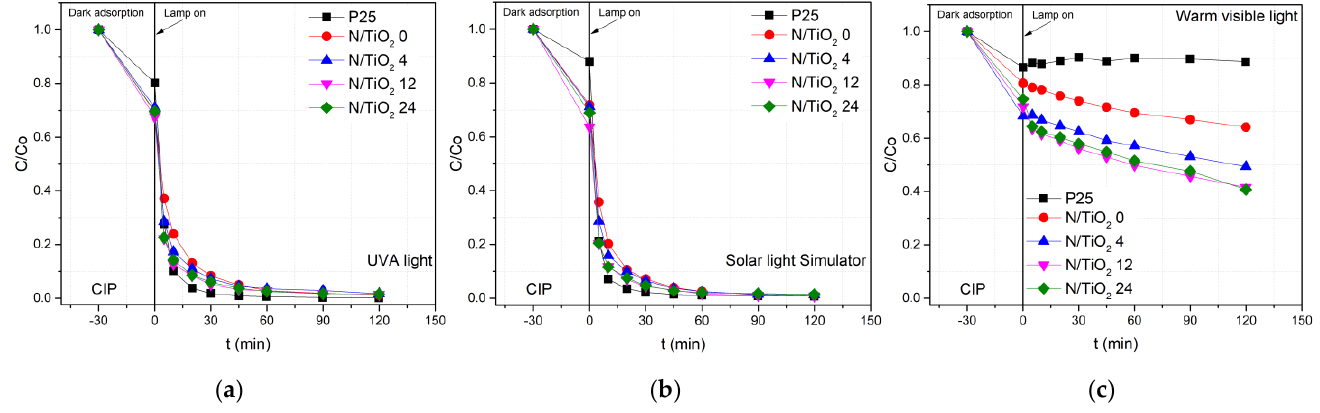
Figure 8. Photocatalytic degradation of ciprofloxacin by Degussa P25 TiO 2 and N/TiO 2 materials under ( a ) UVA light (lamp I), ( b ) Solar light simulator lamp (II), and ( c ) warm visible light (lamp III). Table 4. Parameters obtained from the ciprofloxacin (CIP) degradation under UVA (lamp I), Solar light simulator (lamp II), and warm visible light (lamp III) fitted to a pseudo-first-order kinetic model for N/TiO 2